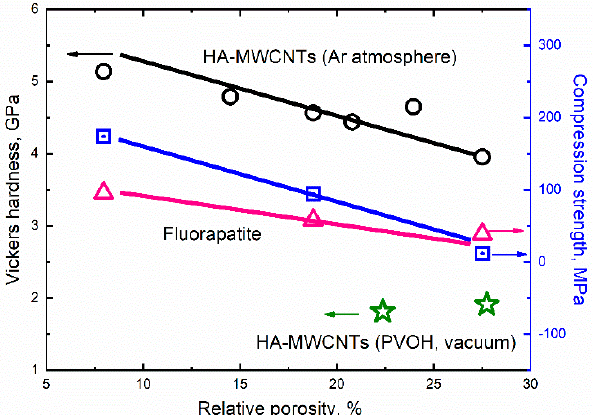
Figure 2. Left axes: Average Vickers hardness vs. relative porosity of the composite HA–MWCNTs sintered in Ar atmosphere, in the range of MWCNTs concentrations from 0 to 0.5 wt.% (open circles) and HA-MWCNTs (0 and 0.5 wt.%MWCNTs mixed with PVOH) sintered in vacuum (open stars). Right axes: Average compression strength [25] vs. relative porosity of the composite HA-MWCNTs (open square) and apatites [49] without MWCNTs additives (open triangles).